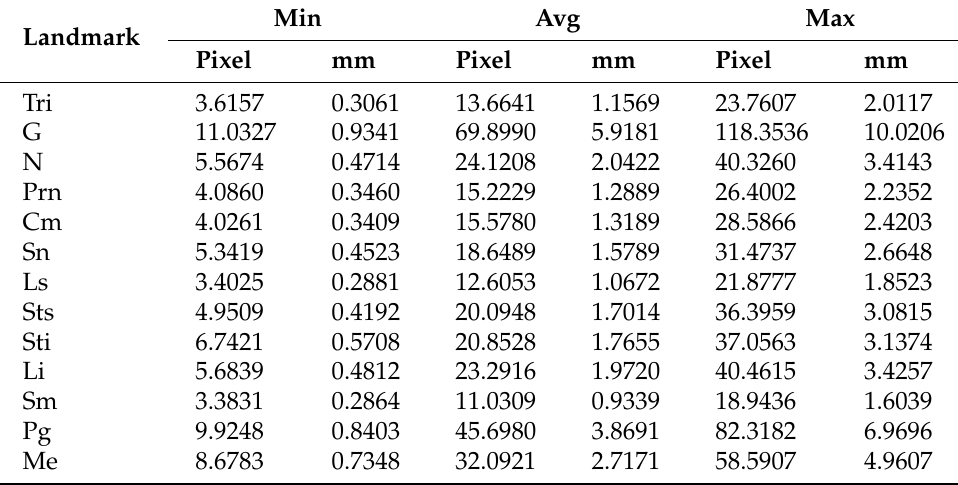
Table 2. Variation of different